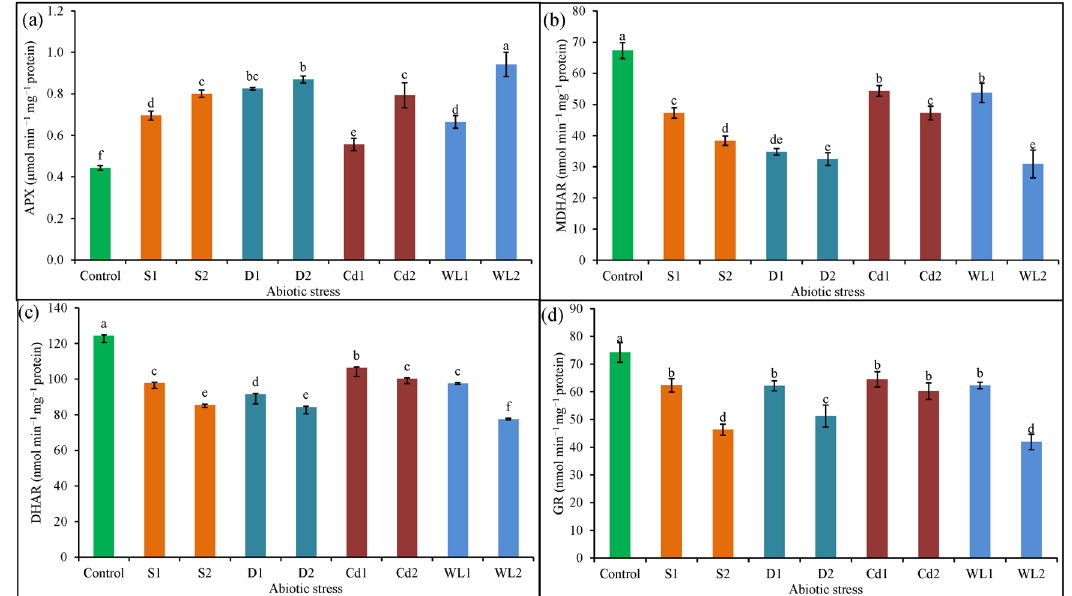
Figure 6: APX ( a ) , MDHAR ( b ) , DHAR ( c ) , and GR ( d ) activities of C. olitorius plants a ff ected by di ff erent abiotic stresses. S 1 , S 2 , D 1 , D 2 , Cd 1 , Cd 2 , WL 1 , and WL 2 represent 200 mM of NaCl, 400 mM of NaCl, 10 days of water de fi cit, 15 days of water de fi cit, 2 mM of CdCl 2 , 4 mM of CdCl 2 , 5 days of waterlogging, and 15 days of waterlogging, respectively. Mean value (± SD ) was calculated from three replicates for each treatment. Values in a column with di ff erent letters are signi fi cantly di ff erent at p ≤ 0.05 applying LSD test.